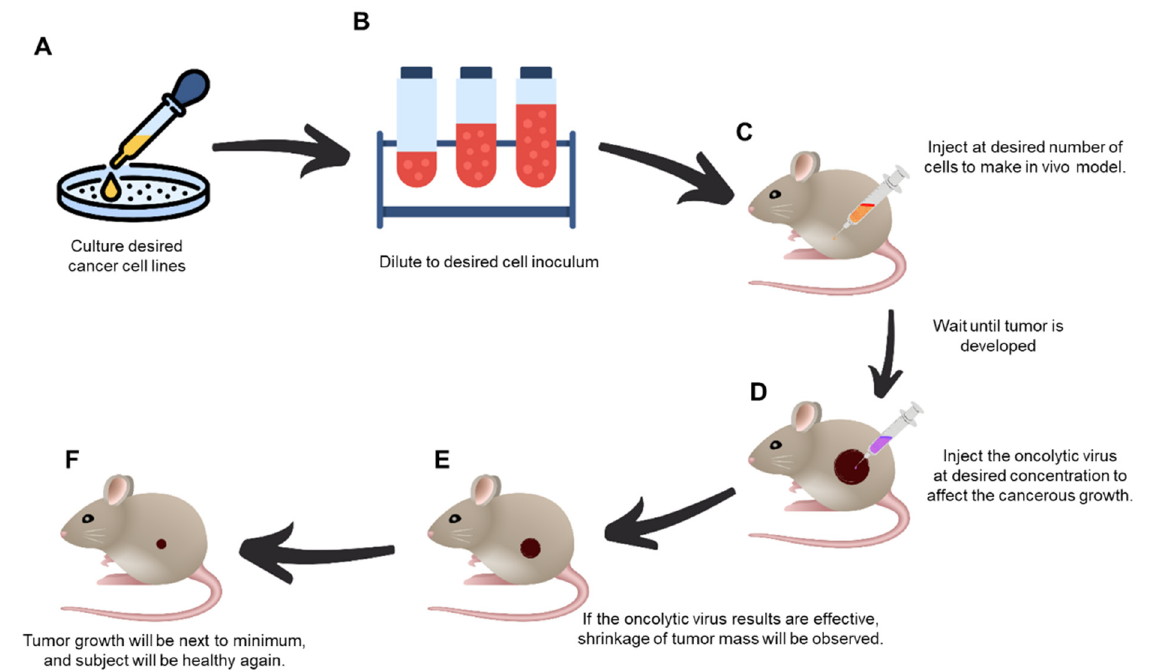
Figure 2. Schematics of the major procedural steps ( A – F ) of in vivo experimental oncolytic virother- apy. ( A ) Culture the desired cancer cell lines at the specific cell numbers, ( B ) dilute them to the desired inoculum concentration, ( C ) inject desired cell numbers to create in vivo model, ( D ) when the tumor has reached the desired volume, the oncolytic virus is injected to inhibit its growth. ( E ) If the oncolytic virus is effective, tumor mass reduction will be observed. ( F ) Tumor growth will be minimal, and the subject will regain health.